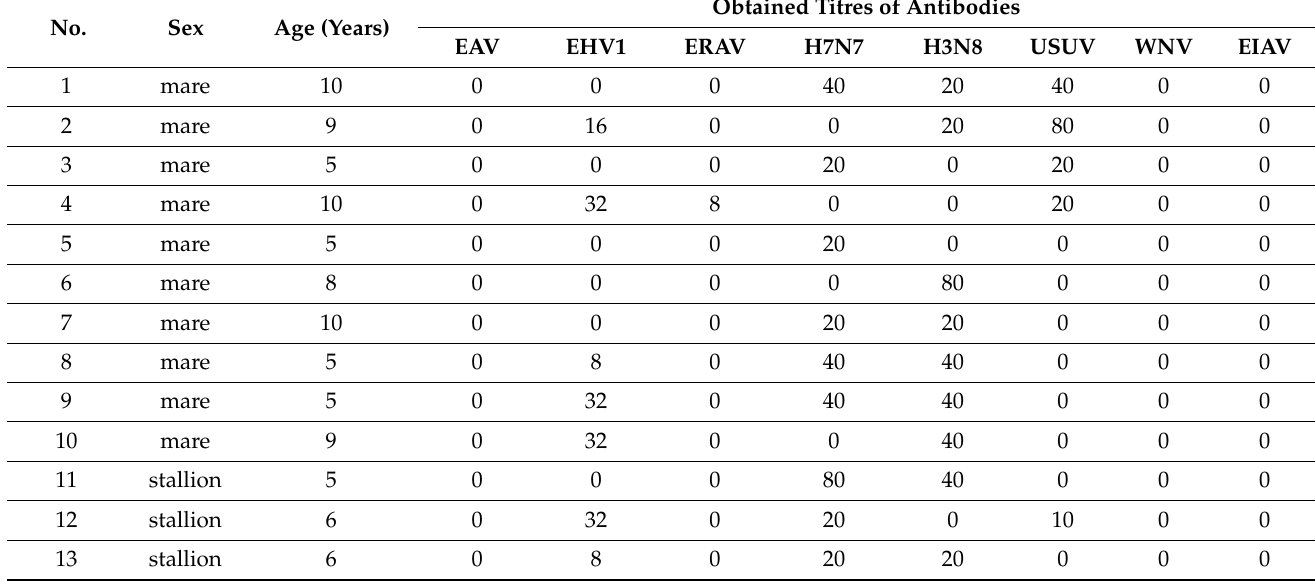
Table 2. The immune status in individual